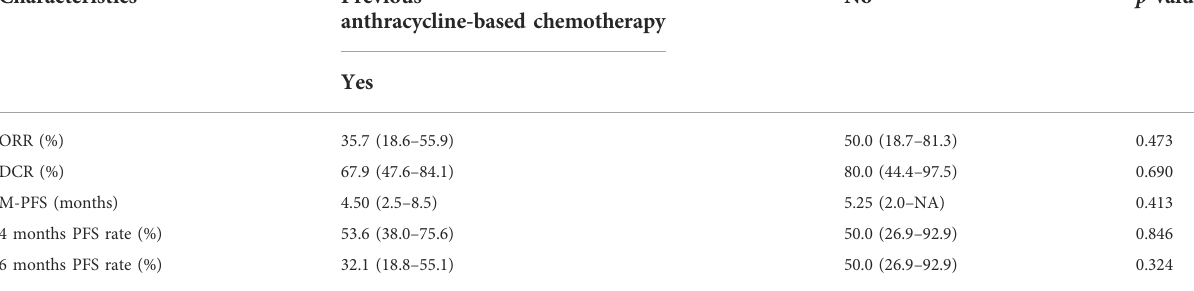
TABLE 5 Clinical ef fi cacy in patients with or without previous anthracycline-based